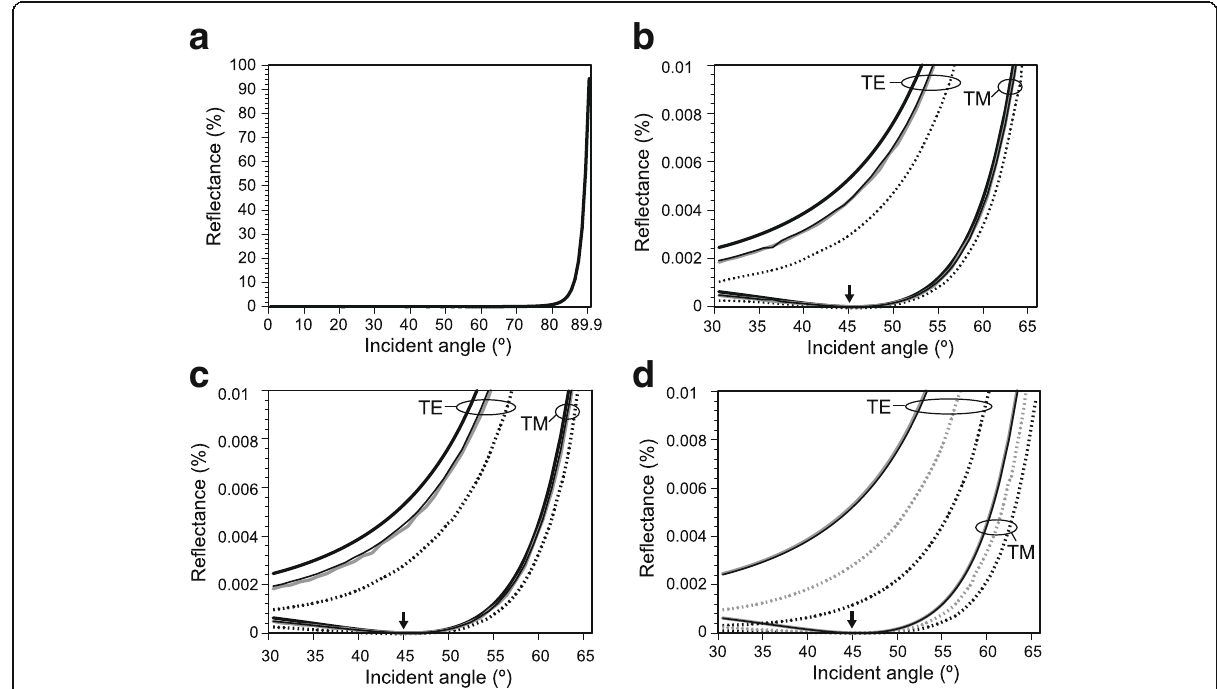
Fig. 5 Simulation of light reflectance (%) with rigorous coupled wave analysis (RCWA) on the flat surface and 3-dimensional models of nipple array (i.e., cone, pillar, and two-tier) at various incident angles. The difference in refractive index between the tunic and seawater was assumed to be 0.01. a Reflectance of 589-nm light of TE wave on the flat surface. b and c , Enlargement of the reflectance curves on the flat surface and on the nipple array arranged in grid pattern ( b ) and honeycomb pattern ( c ). Lines in b and c : thick line, flat surface; thin line, cone; broken line, pillar; gray line, two-tier. d Reflectance of 400-nm (black) and 589-nm (gray) light on the flat surface and on the pillar-model arranged in honeycomb pattern. Line in d : solid line, flat surface; broken line,